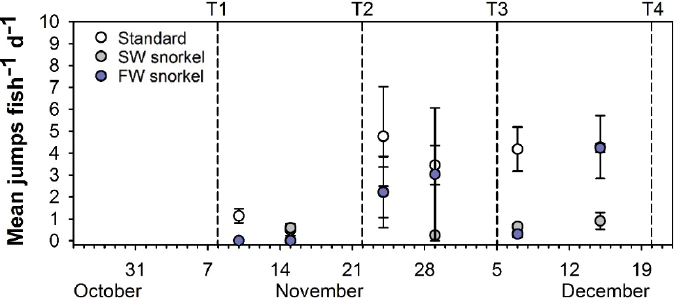
Fig. 5. Mean number (±SE) of jumps per fish per day by farmed At- lantic salmon in standard (white circles), SW snorkel (grey circles) and FW snorkel cages (blue circles) at weekly assessments. Values for each cage type are aggregates from replicate cages (n = 3 replicates). See Fig. 1 legend for details of cage treatments. The 4 sampling times (T1 to T4) are indicated by dashed